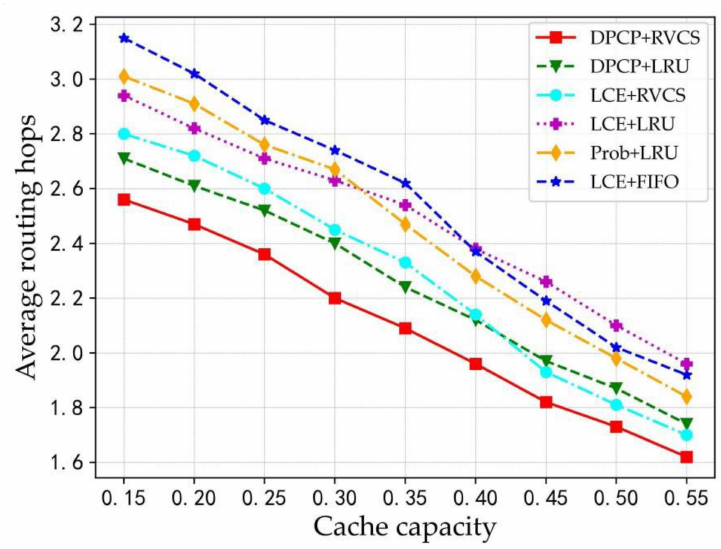
Figure 6. The influence of cache capacity on the average routing